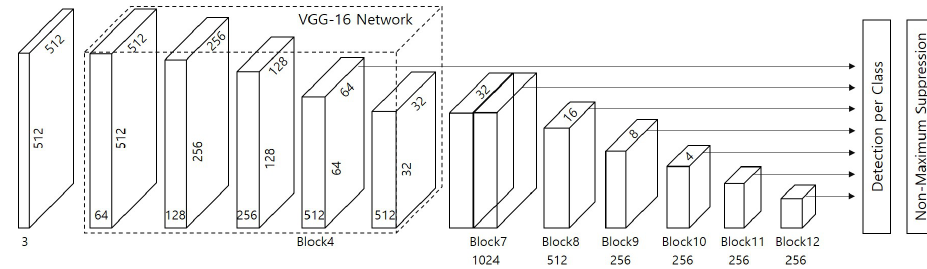
Figure 5. Network model of the original SSD with the input size of 512 × 512